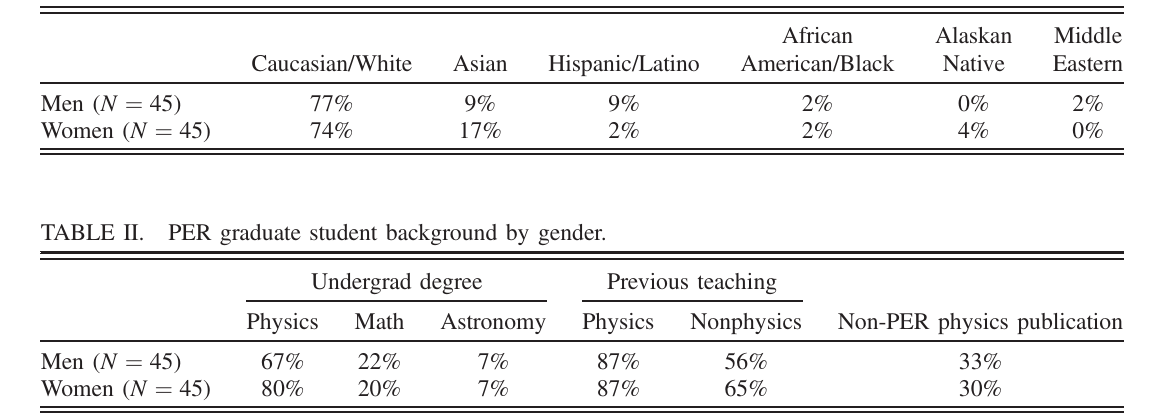
TABLE I. PER graduate student ethnicity by gender.